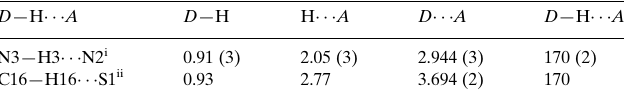
Hydrogen-bond geometry (A˚ , (cid:2)